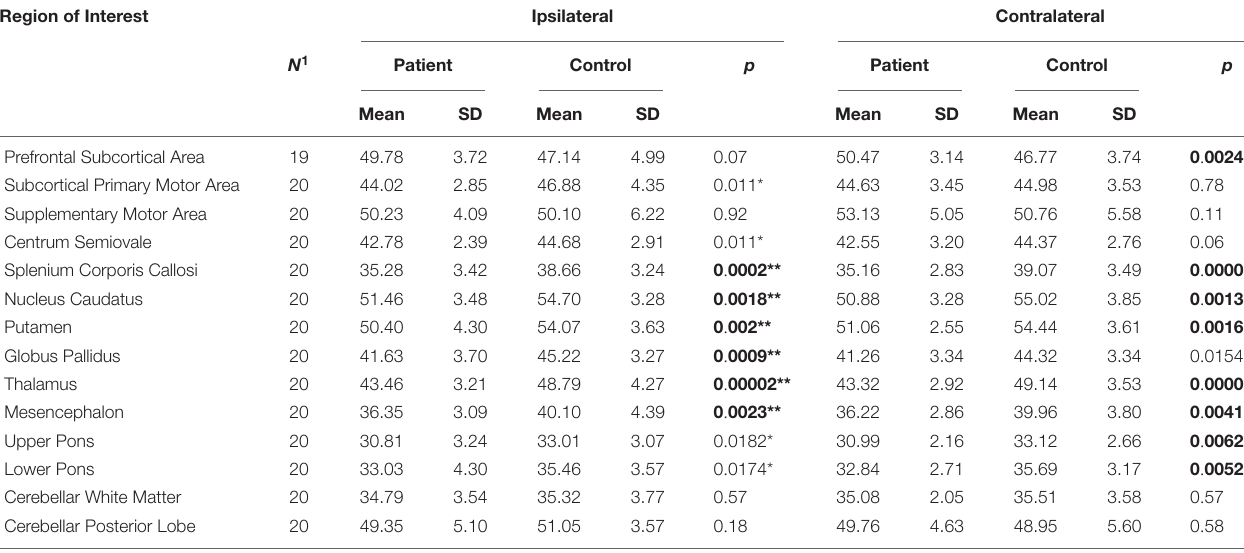
TABLE 2 | Paired t -tests between patients and controls for relative proton densities measured in brain hemispheres contralateral or ipsilateral to the more affected body side as indicated. Region of Interest Ipsilateral Contralateral N 1 Patient